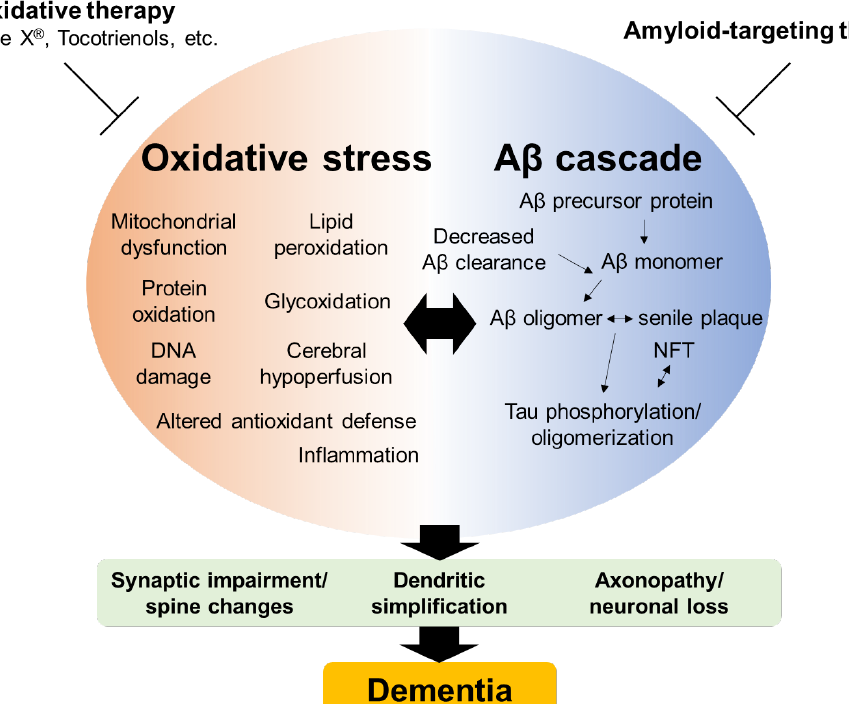
Figure 2. Schematic illustration of oxidative stress and amyloid β (A β ) cascade in Alzheimer’s disease. There is interplay between oxidative stress and the A β cascade, resulting in neuronal dysfunction and death. Antioxidative supplements such as Twendee X ® and tocotrienols might be hopeful for preventing dementia.